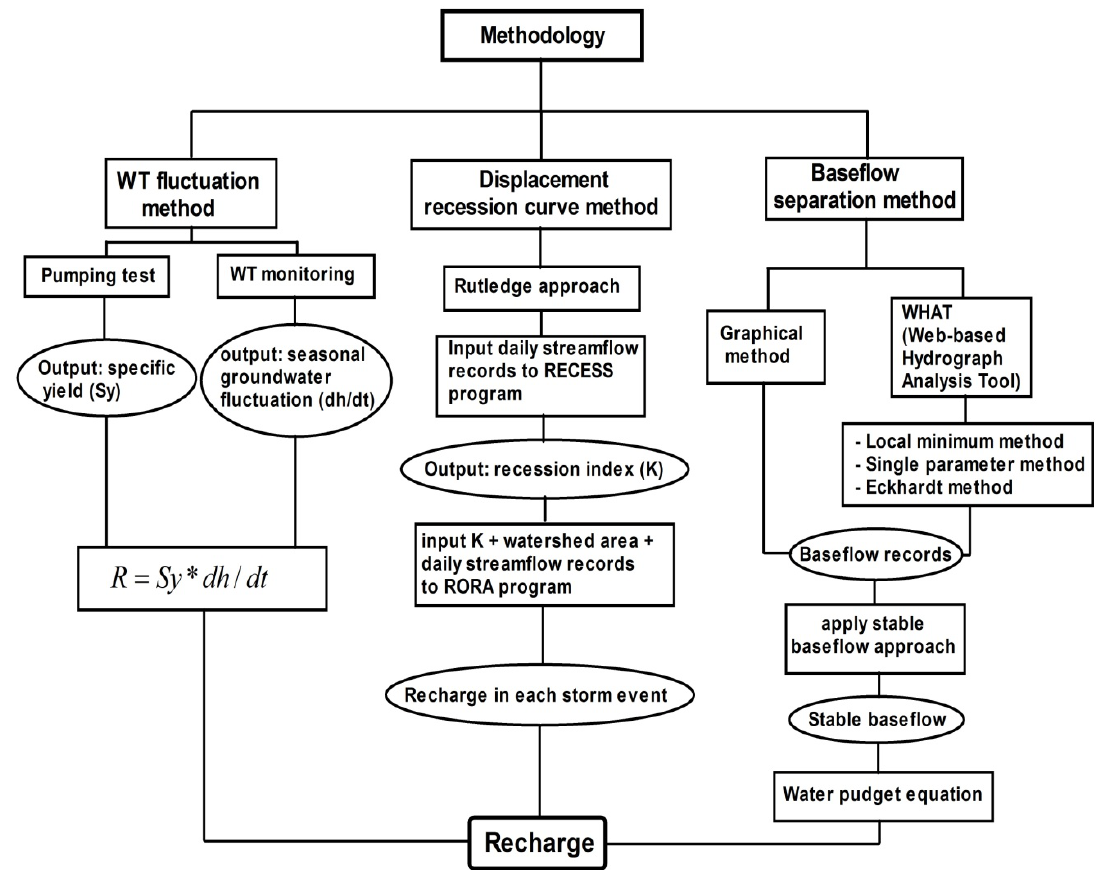
Figure 2. Flowchart showing the methodology of the recharge estimation by base-flow separation methods, the displacement recession curve method and the water table (WT) fluctuation